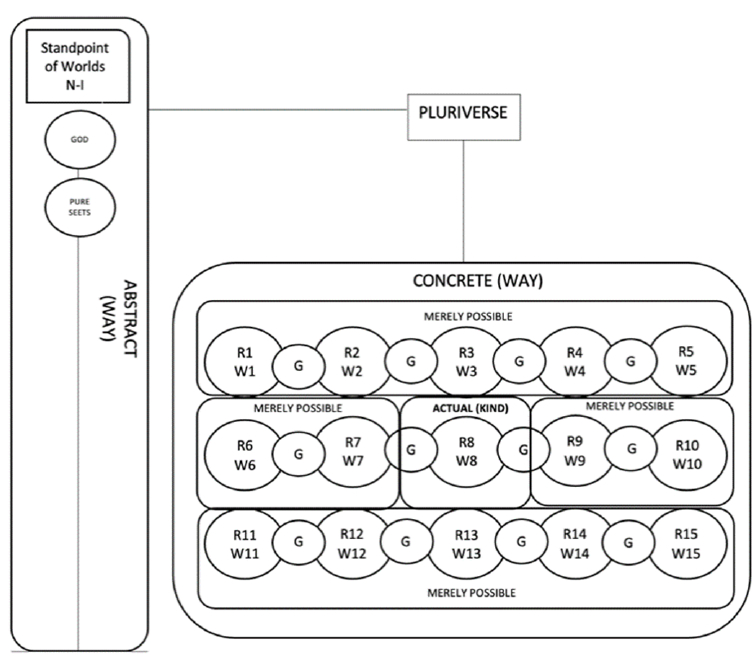
Figure 6. Nature of the Pluriverse (ii).